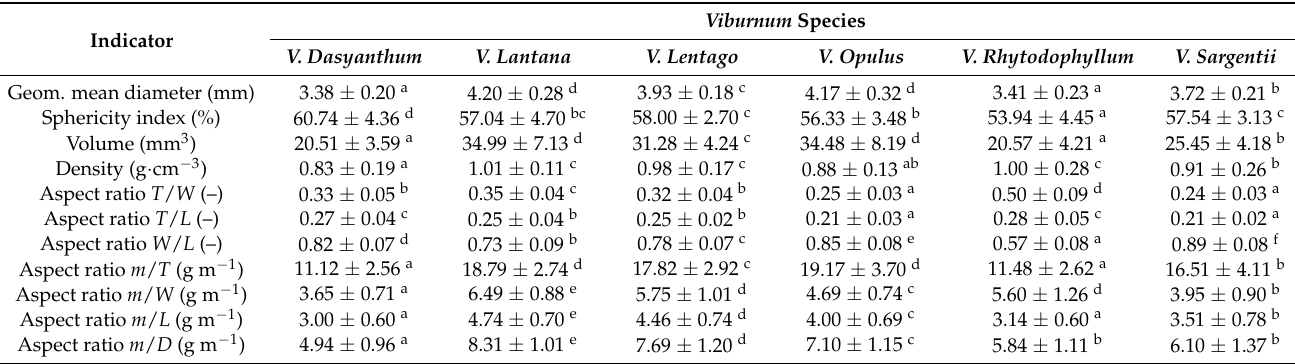
Table 1. Physical attributes of seeds of selected Viburnum species (mean values ± standard deviation), with an indication of significant